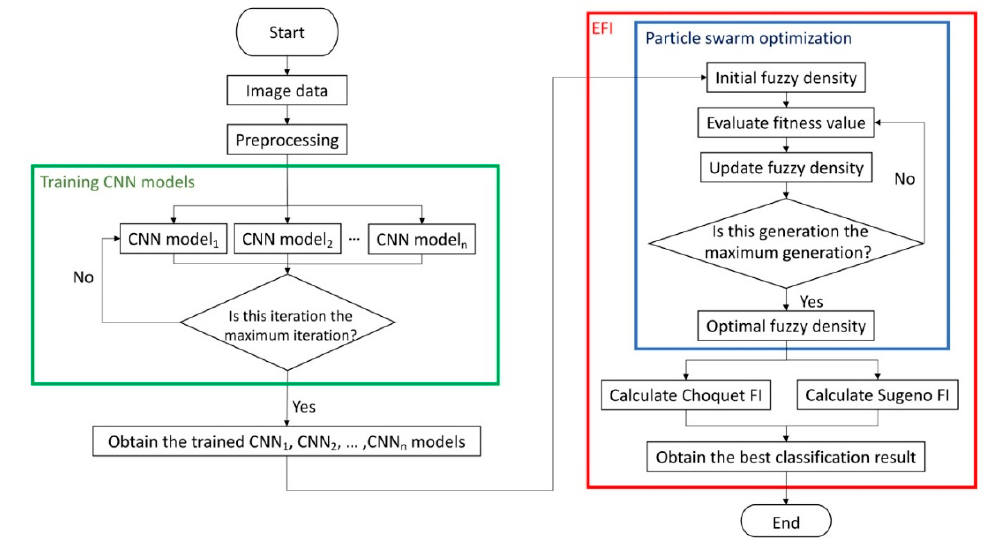
Figure 3. Flowchart of an evolutionary-fuzzy-integral (EFI)-based CNN.